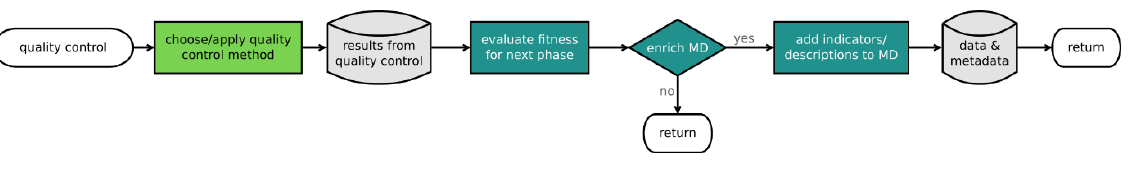
Figure 4. Quality assurance workflow alongside the data life cycle for spatial research data. Abbre- viations: DQ – data quality, MD – metadata, DM – data maturity.